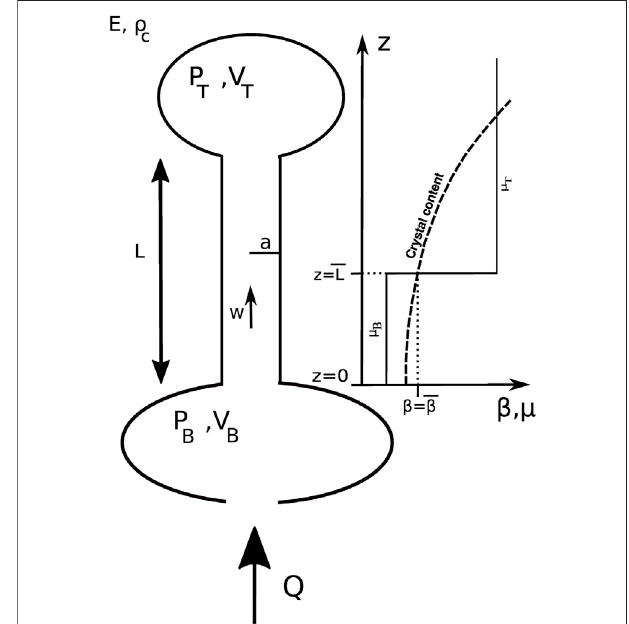
FIGURE7| Schematicrepresentationofthecomponentsofthephysical model described in Section 5.2 , including the key associated variables and parameters. Two reservoirs with volumes V B and V T , for bottom ( B ) and top ( T ),respectively,containmagmaatpressures P B and P T .Theyarefedby magma from adeeper source region with constant fl ux Q . The pipe linking the two reservoirs has radius a and length L , and the magma fl ows through it at velocity w . Inside the pipe, the crystal concentration β per volume reaches the value (cid:2) β when z (cid:1) (cid:2) L . Above (cid:2) L the viscosity increases from μ B to μ T